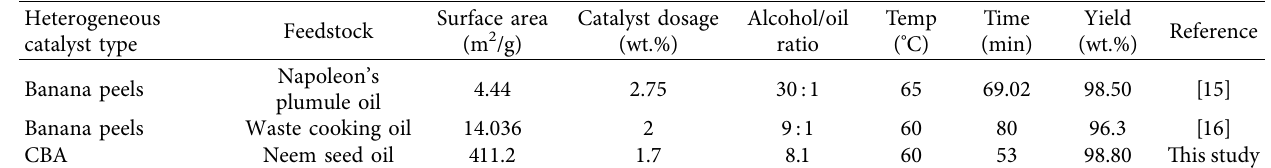
Table 5: Comparison of the different performance of catalyst for biodiesel production.